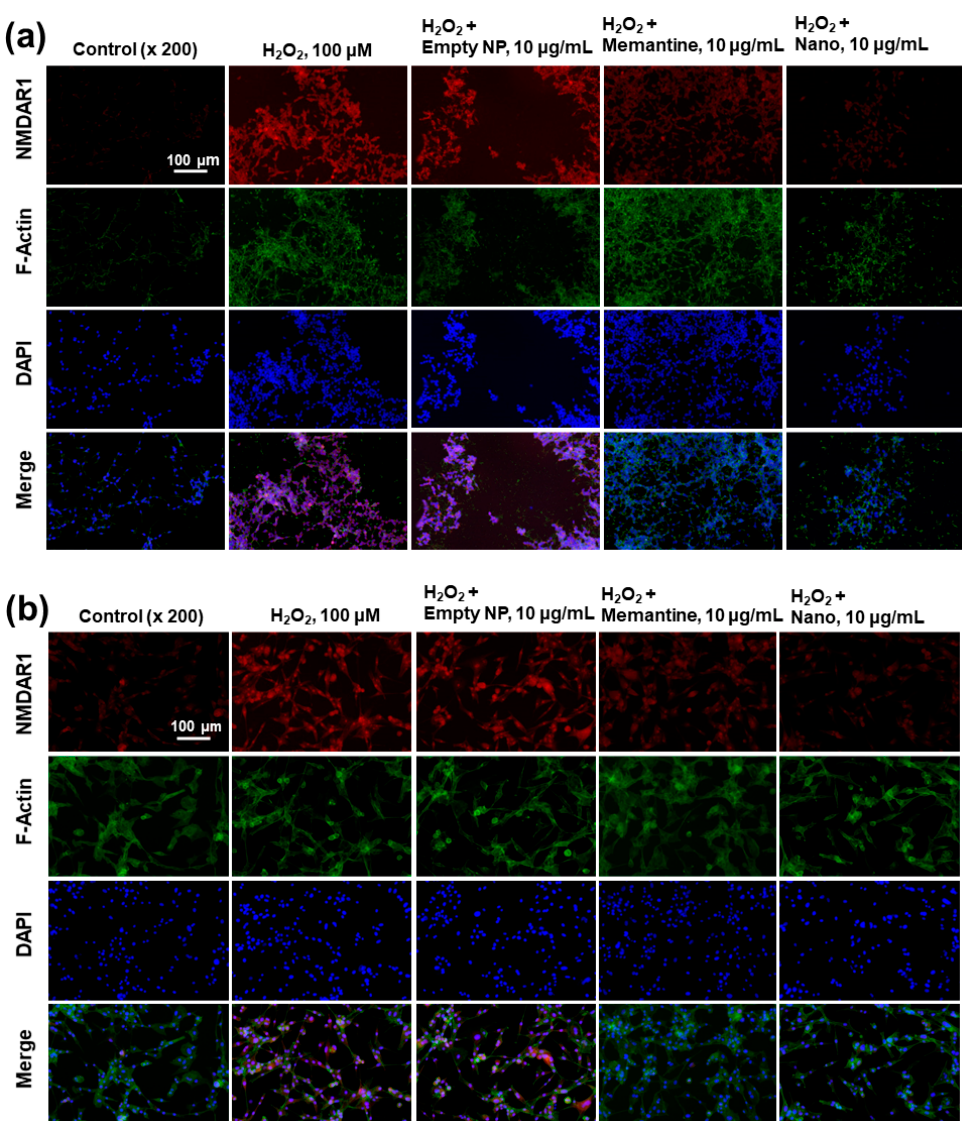
Figure 10. The effect of memantine and/or bCDsuMema nanoparticles on the expression of NMDAR1 in SH-SY5Y cells ( a ) and U87MG cells ( b ) under oxidative stress. For the observation of NMDAR1 changes of cells, U87MG cells (1 × 10 5 ) or SH-SY5Y cells (1 × 10 5 ) were pre-treated with memantine or bCDsuMema nanoparticles for 1 h and then treated with 100 µM H 2 O 2 for 6 h. Immunofluorescence staining of cells was performed in a similar manner to that shown in Figure 9. Nano = bCDsuMema